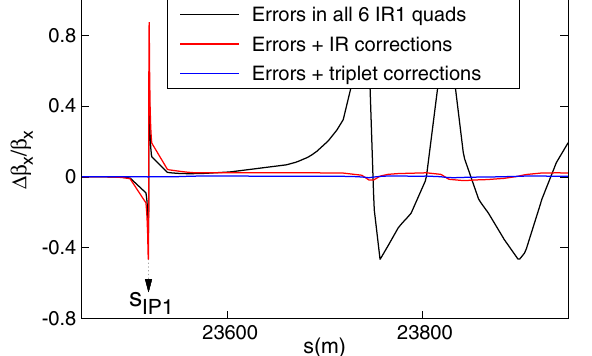
FIG. 8. Phase plots before corrections (black) and after IR (red) and triplet-by-triplet (blue) corrections are applied. The jumps between the arcs disappear when IR corrections are applied, but a large step can still be seen between the arcs and the IR. After applying triplet-by-triplet corrections, the plot becomes completely flat.